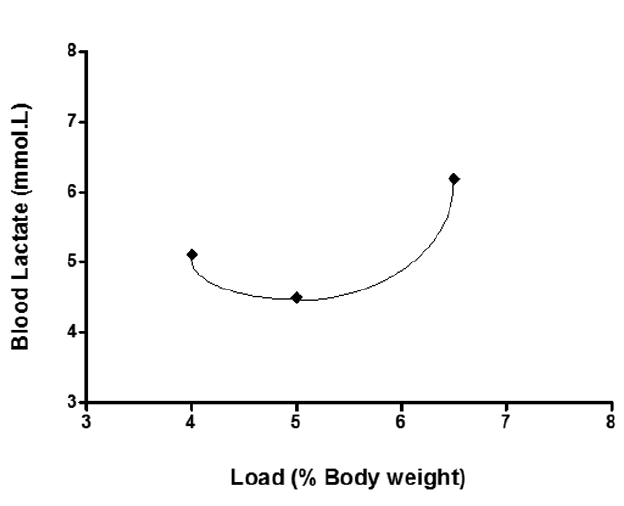
Figure 1. Blood lactate concentration curve versus workload of one rat during the LACmin obtained by polynomial fit of 2 nd degree. teste3 The equation y = 0.6947 x 2 – 6.862 x + 21.443 enabled the calculation of the BLM concentration and its workload (% bw).